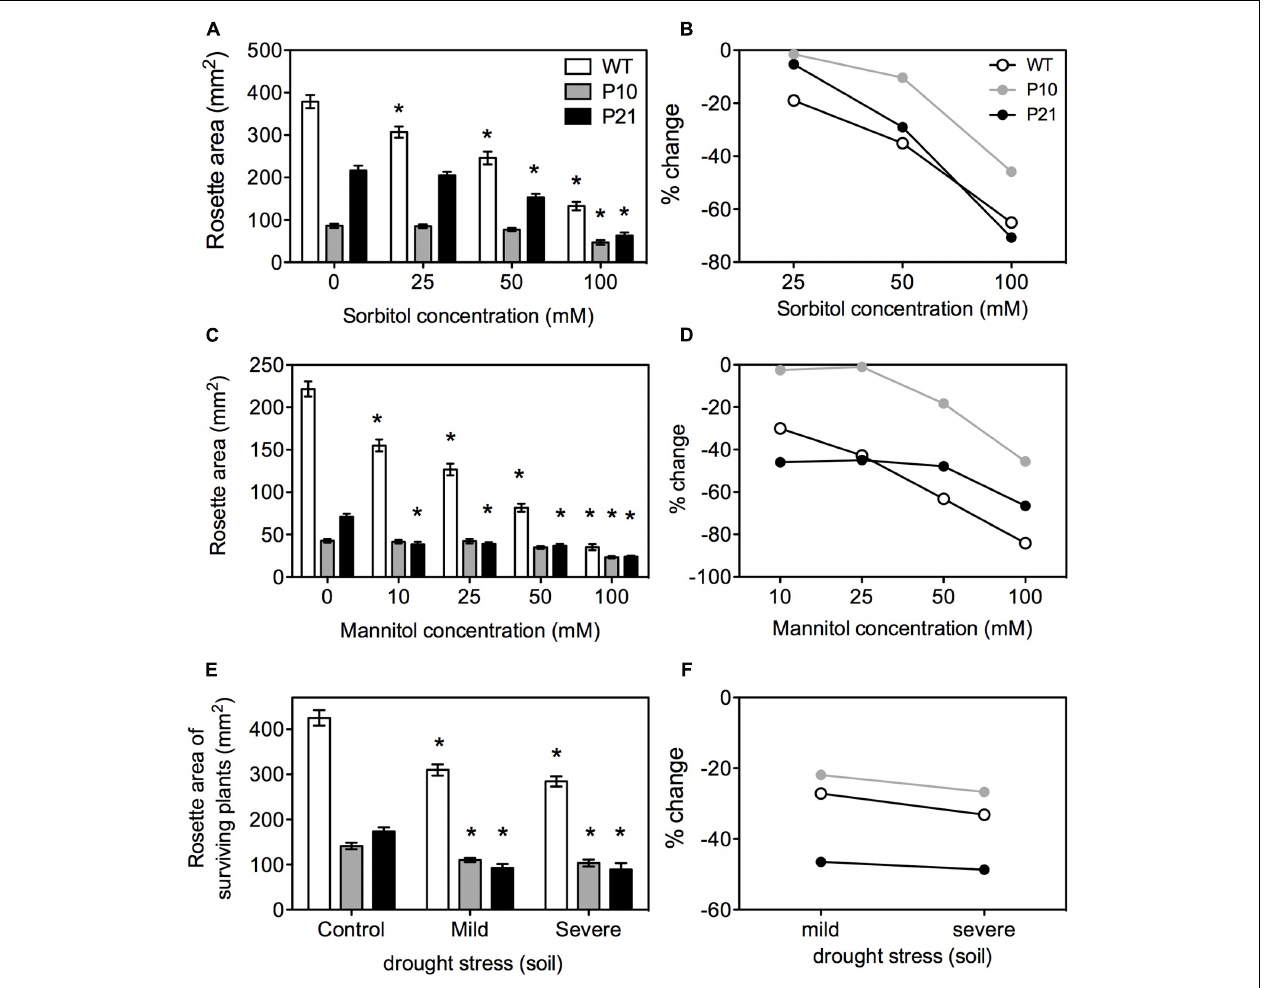
FIGURE 6 | Effect of osmotic and drought stress on rosettes of WT and PID overexpression lines. Rosette area under increasing concentrations of sorbitol at 25 DAS; Error bars: ± SE (A) and corresponding percent changes; Error bars represent error of propagation (B) . Rosette area under increasing concentrations of mannitol at 25 DAS; Error bars: ± SE (C) and corresponding percent changes; Error bars represent error of propagation (D) . Rosette area measurements under soil drought stress at 25 DAS (Error bars: ± SE) with percent changes (E,F) . Asterisks represent statistical significant differences with the respective controls ( n = 40–50; P <